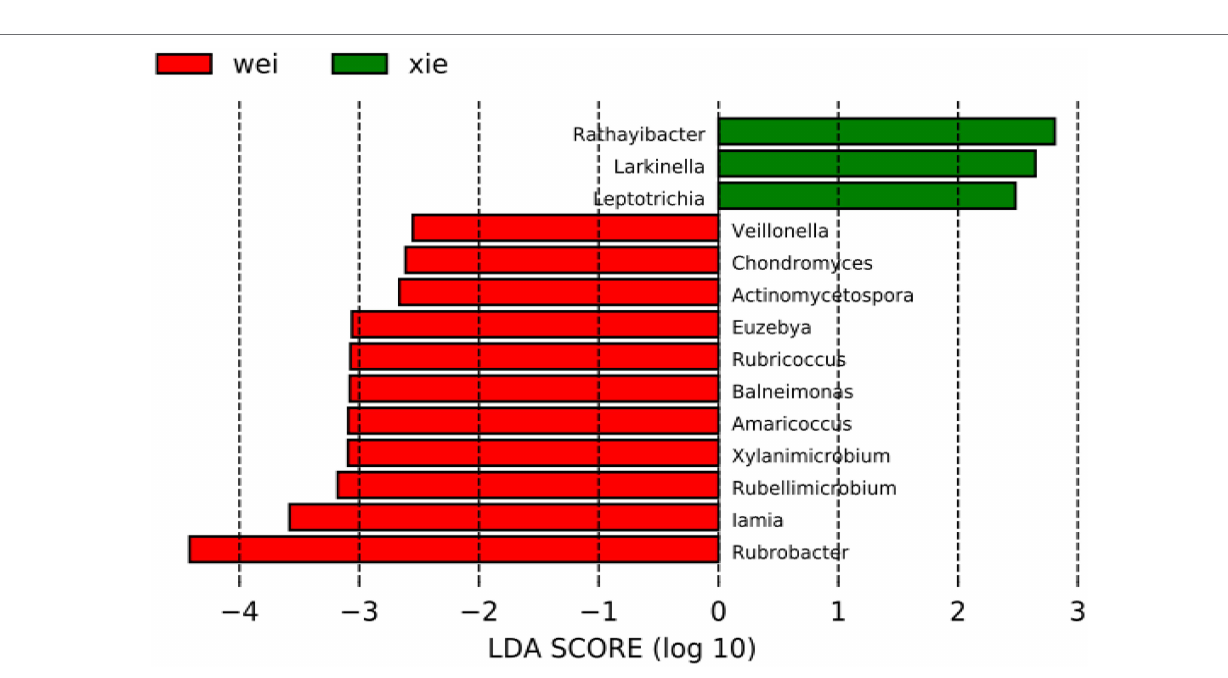
FIGURE 5 | Linear discriminant analysis (LDA) and effect size (LEfSe) assay of microbial communities of the Weizhou and Xieyang Islands. The size of differentiation between Weizhou and Xieyang Islands was identified using LDA score with a threshold value of 2.5. “wei” = soil samples from Weizhou Islands. “xie” = soil samples from Xieyang